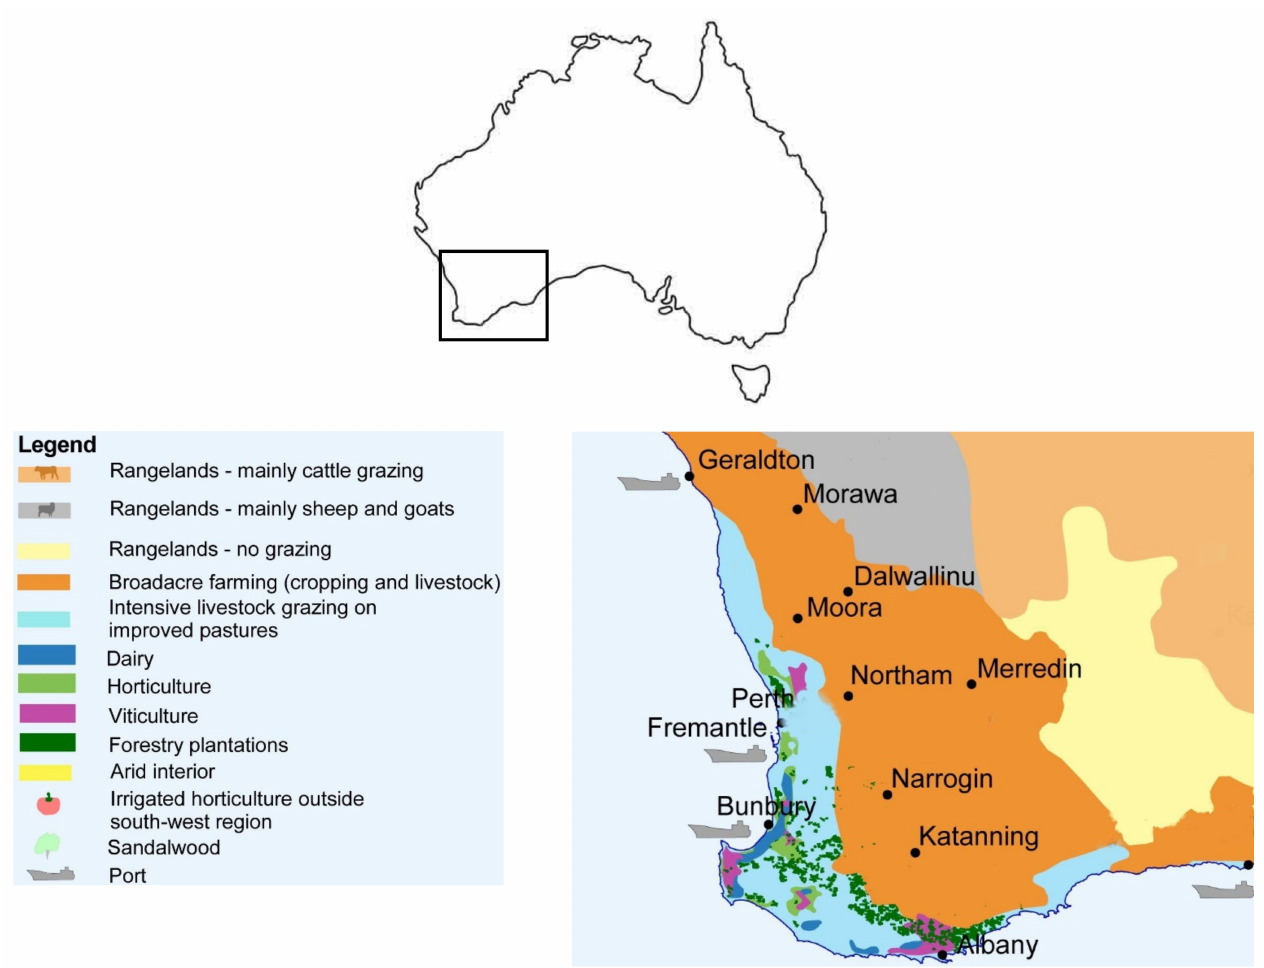
Figure 1. Land use in South-West of Australia. Source: Based on a DPIRD map available at: https://researchlbrary.agric.wa. gov.au/gis_maps/10/ (accessed on 12 November